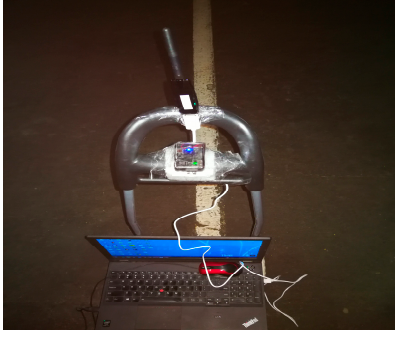
Figure 6. Test site in the underground garage.